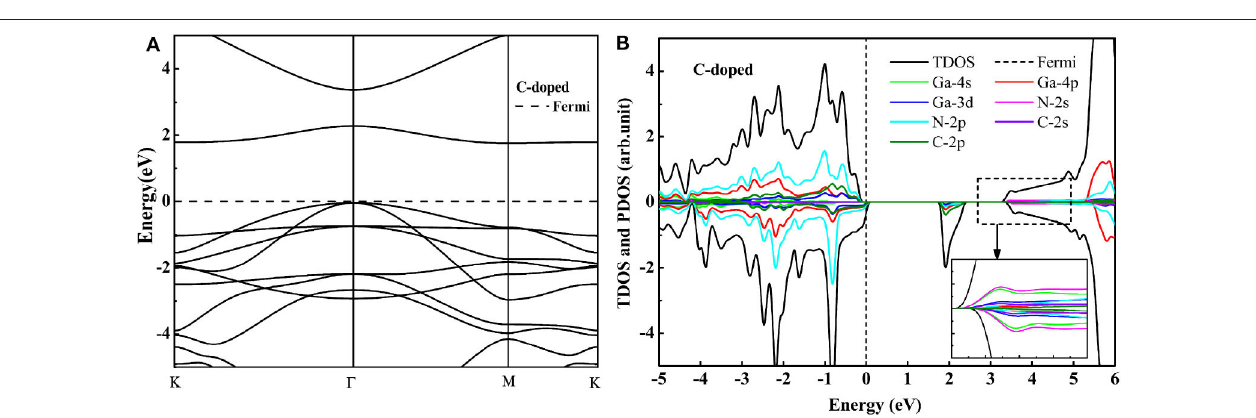
, and band gap E g with the PBE and HSE06 functional. − N